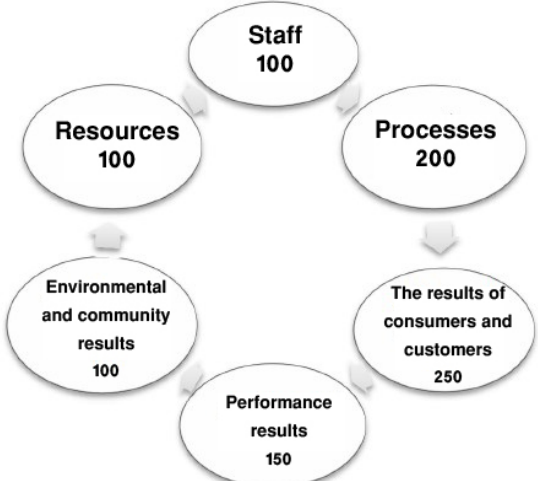
Figure 1. The block diagram of Iran National Quality Award (INQA) [27]